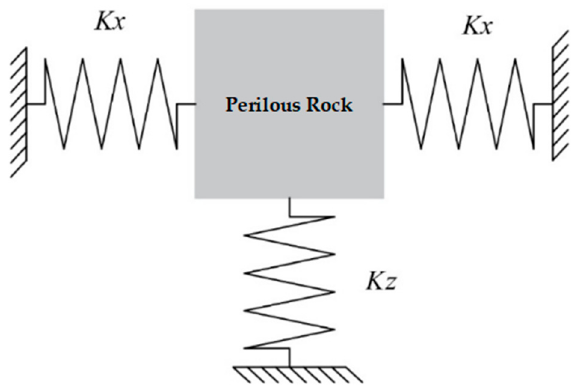
Figure 2. Dynamic characteristic model of perilous rock.